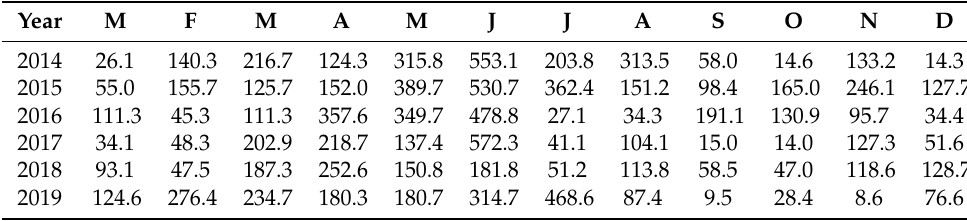
Table 1. Monthly rainfall levels in the study area from 2014 to 2019 (unit: mm).